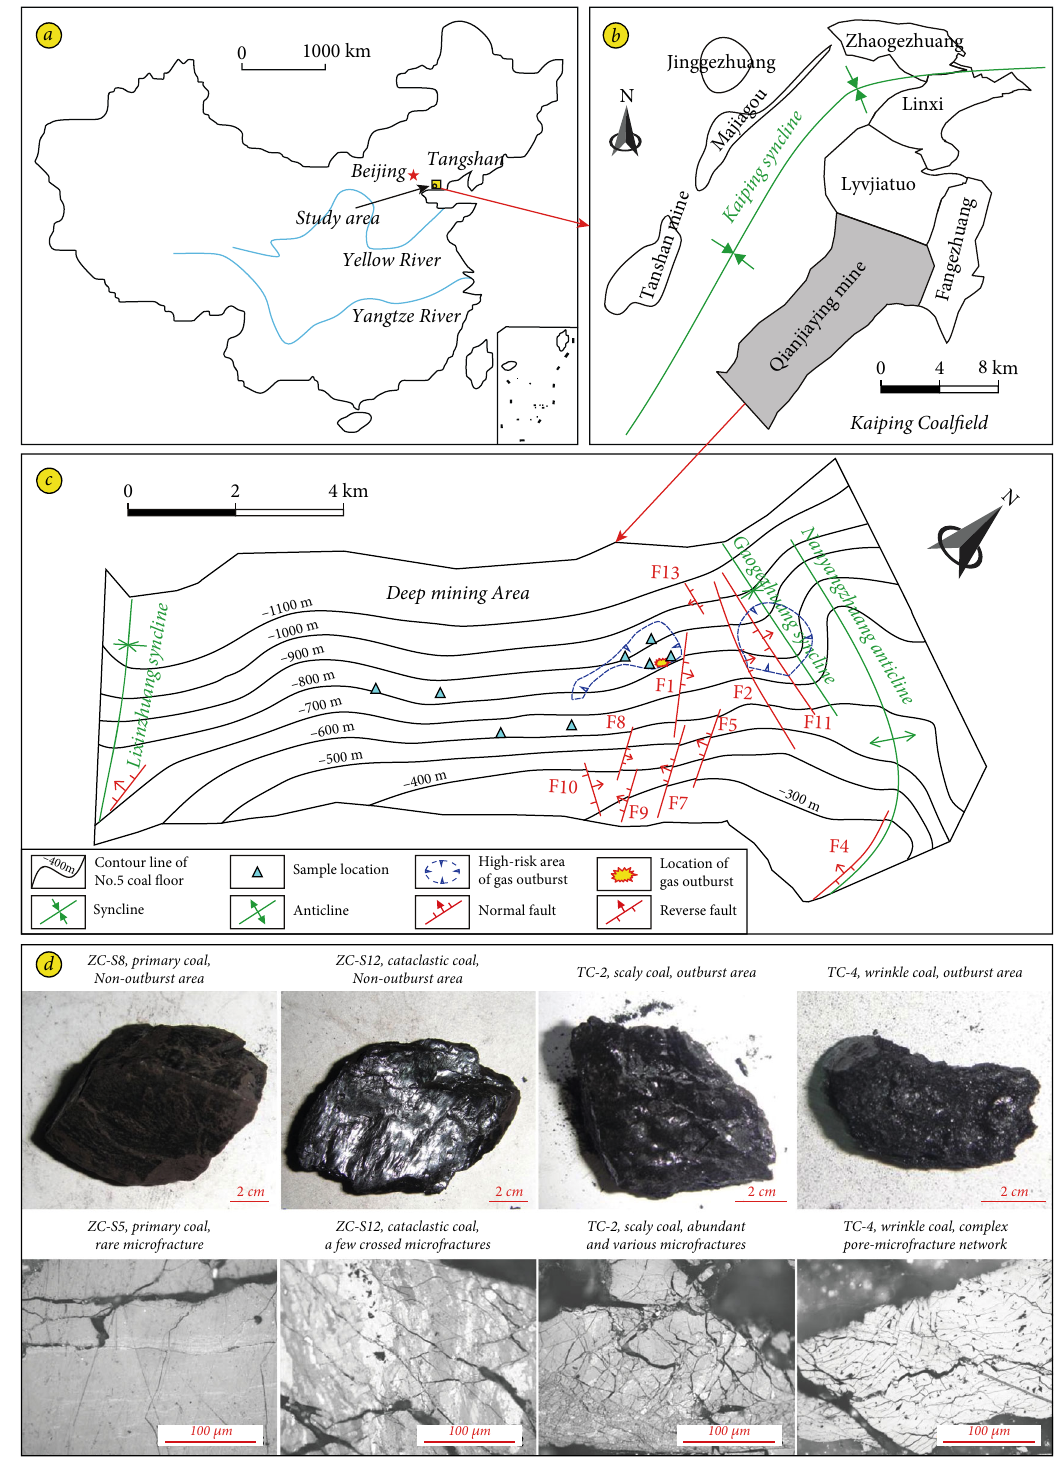
Figure 1: Location of the study area (a, b), structural outline map of the coal mine (c), and macroscopic and microscopic characteristics of the coal samples